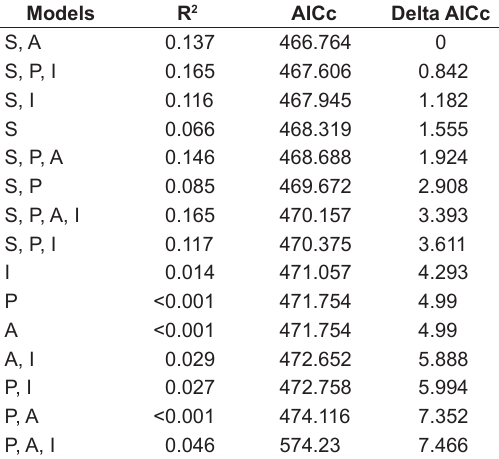
Figure 3. Number of papers published in major countries. Table 1. Models generated and AIC values for combina- tions of variables: Sanitation (S), Supply (A), GDP (P) and HDI (I).